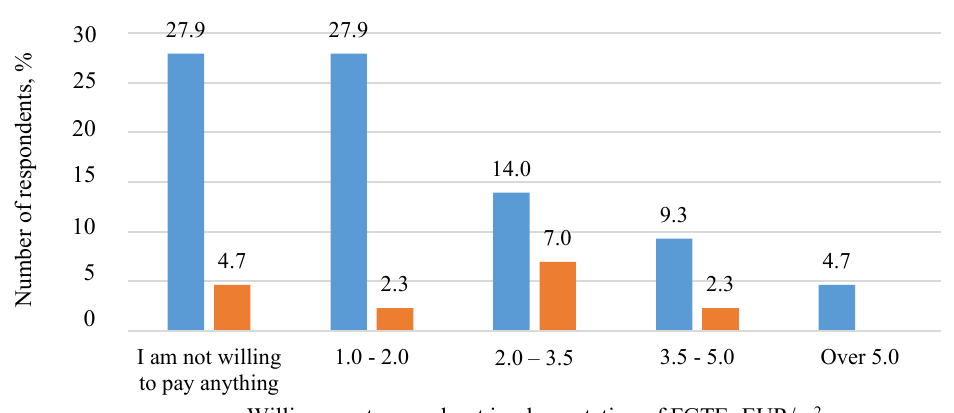
Fig. 7. Respondents’ willingness to pay about installation of FGTE from education level perspective.